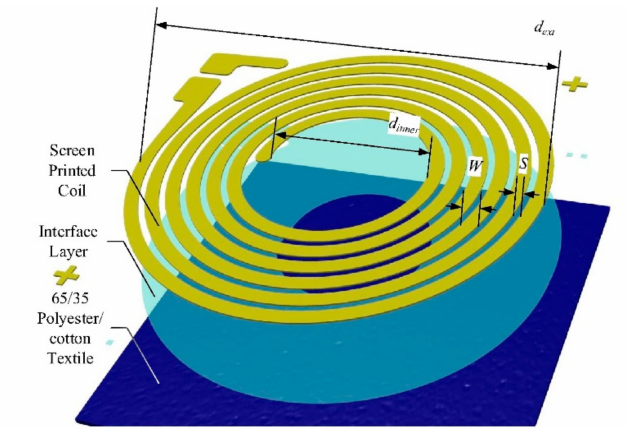
Figure 2. Design of circular-spiral flat coil. The external diameter of the coil is designed based on the application, and other parameters are optimized for the maximized unloaded Q factor. The coils are printed on interface-coated 65/35 polyester/cotton